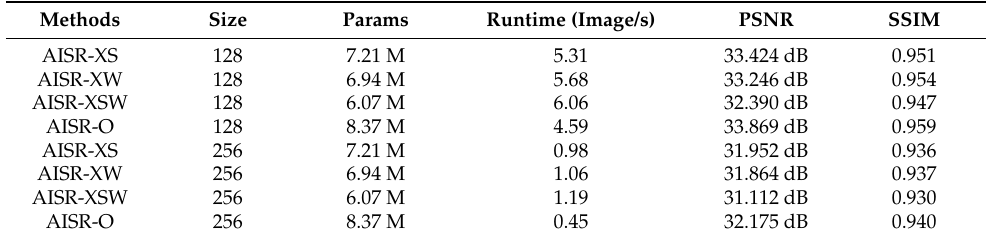
Table 2. Impact of shallow feature extraction part and big attention layer on 4 × anime super-